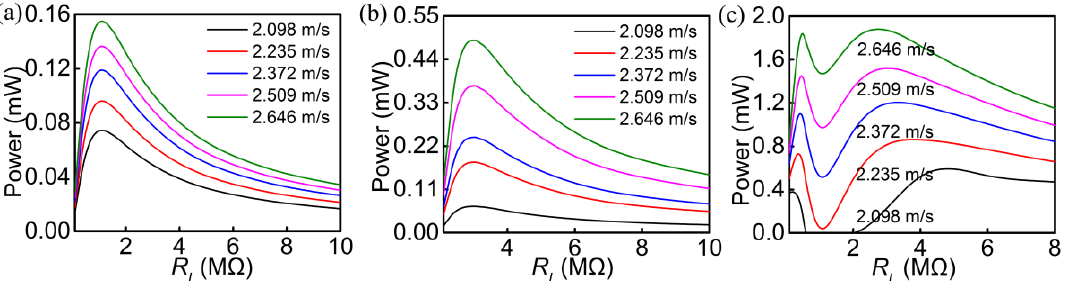
Figure 6. Numerical output power versus load resistance: ( a ) Weak coupling k 2 /(4 ζ + 4 ζ 2 ) = 0.029; ( b ) critical coupling k 2 /(4 ζ + 4 ζ 2 ) = 1; ( c ) strong coupling k 2 /(4 ζ + 4 ζ 2 ) = 2.9.